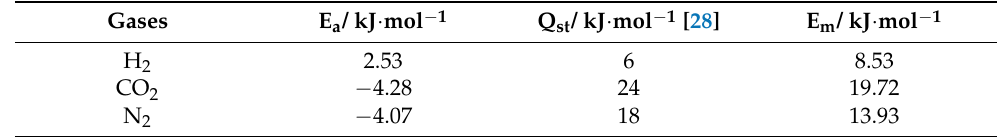
Table 3. E a , Q st , and E m values of gases (H 2 , CO 2 , and N 2 ) calculated from the Arrhenius formula for the Nb/SiO 2 membrane with n Nb = 0.08 at a pressure difference of 0.1 MPa.